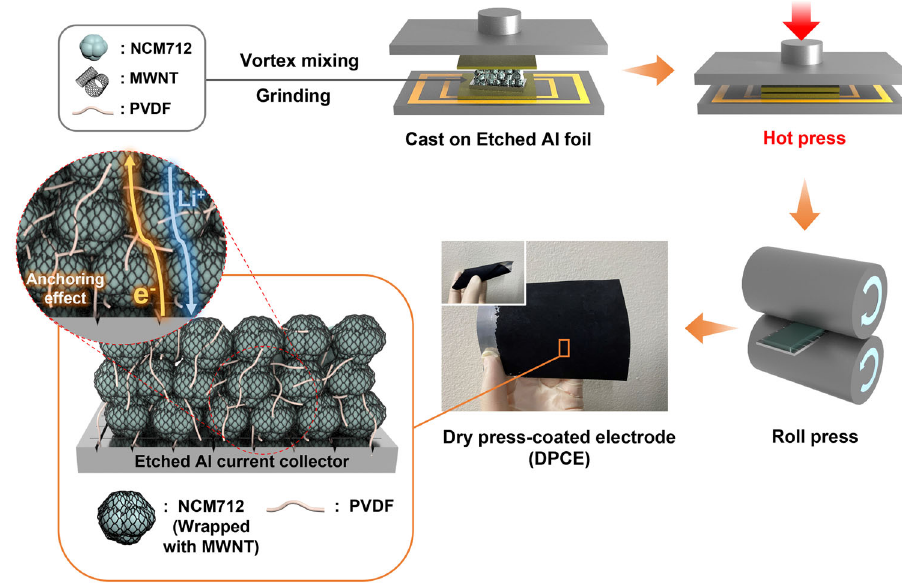
Fig. 1 | Fabrication of the dry press-coated electrode (DPCE). Schematic illustration of the fabrication procedure and structural design of the